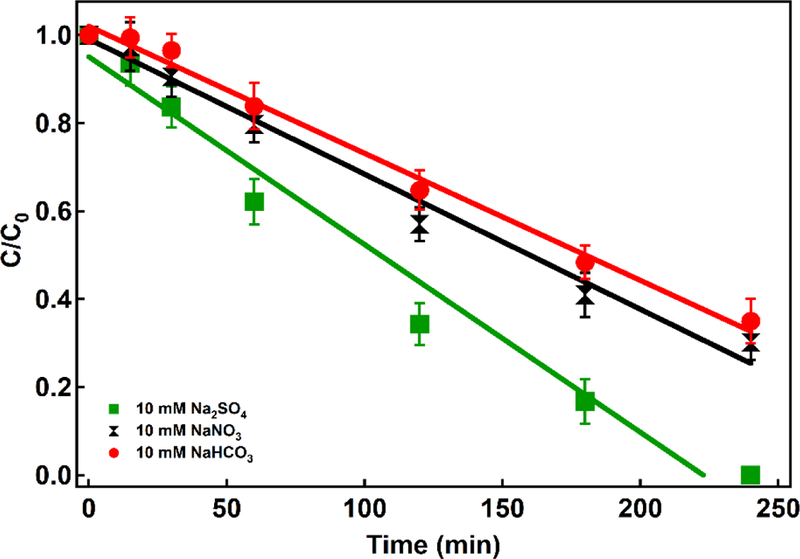
Degradation profile of 4-CP in different background electrolytes (Conditions: Fe2+: 80 ppm, current density: 16.94 mA cm−2, 10 mg L−1 Pd as Pd/Al2O3, pH=3, and 4-CP: 200 ppm)